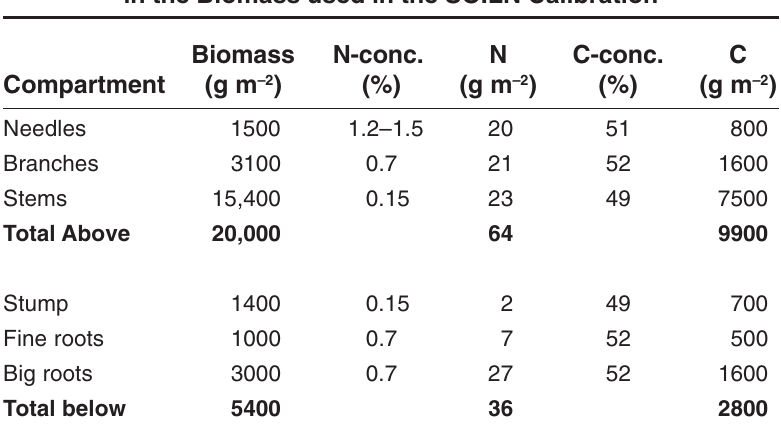
N and C Content and Pool